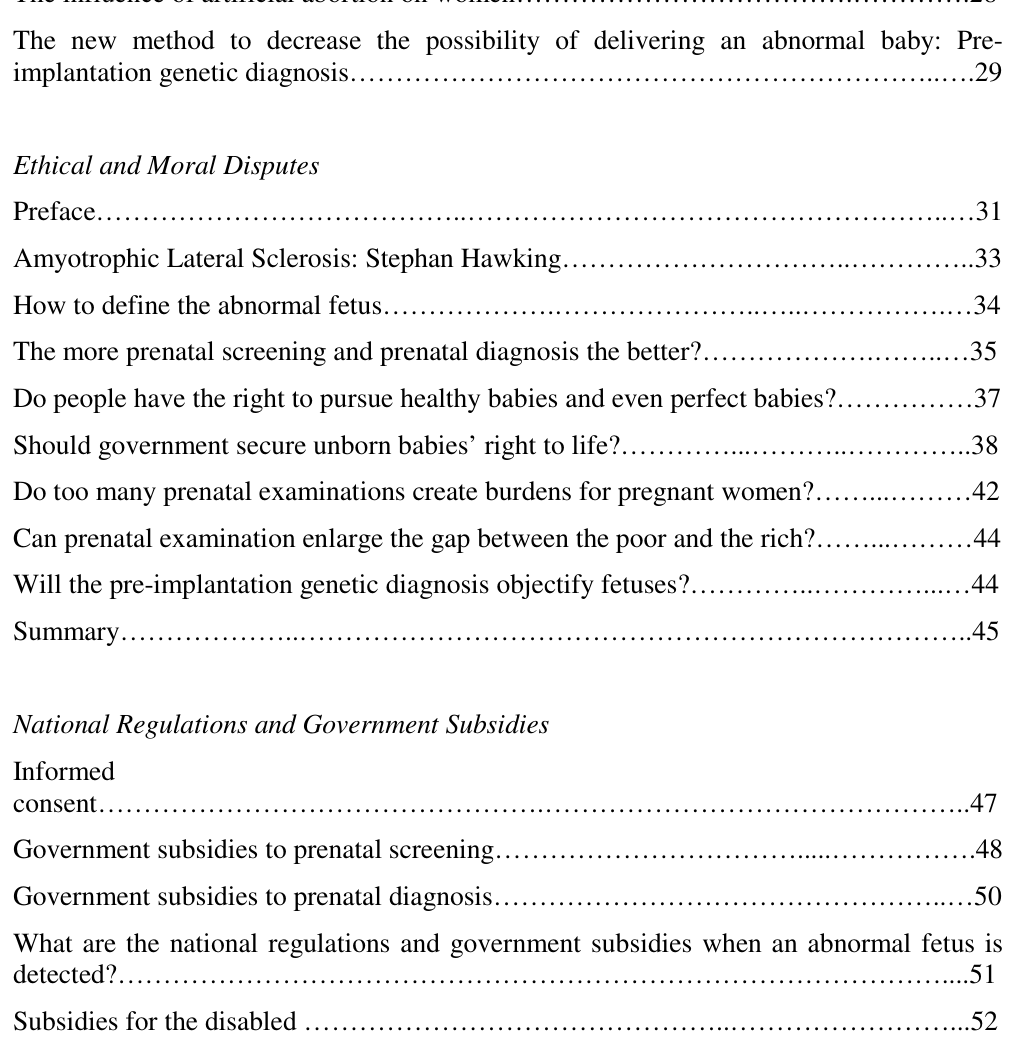
What are the national regulations and government subsidies when an abnormal fetus